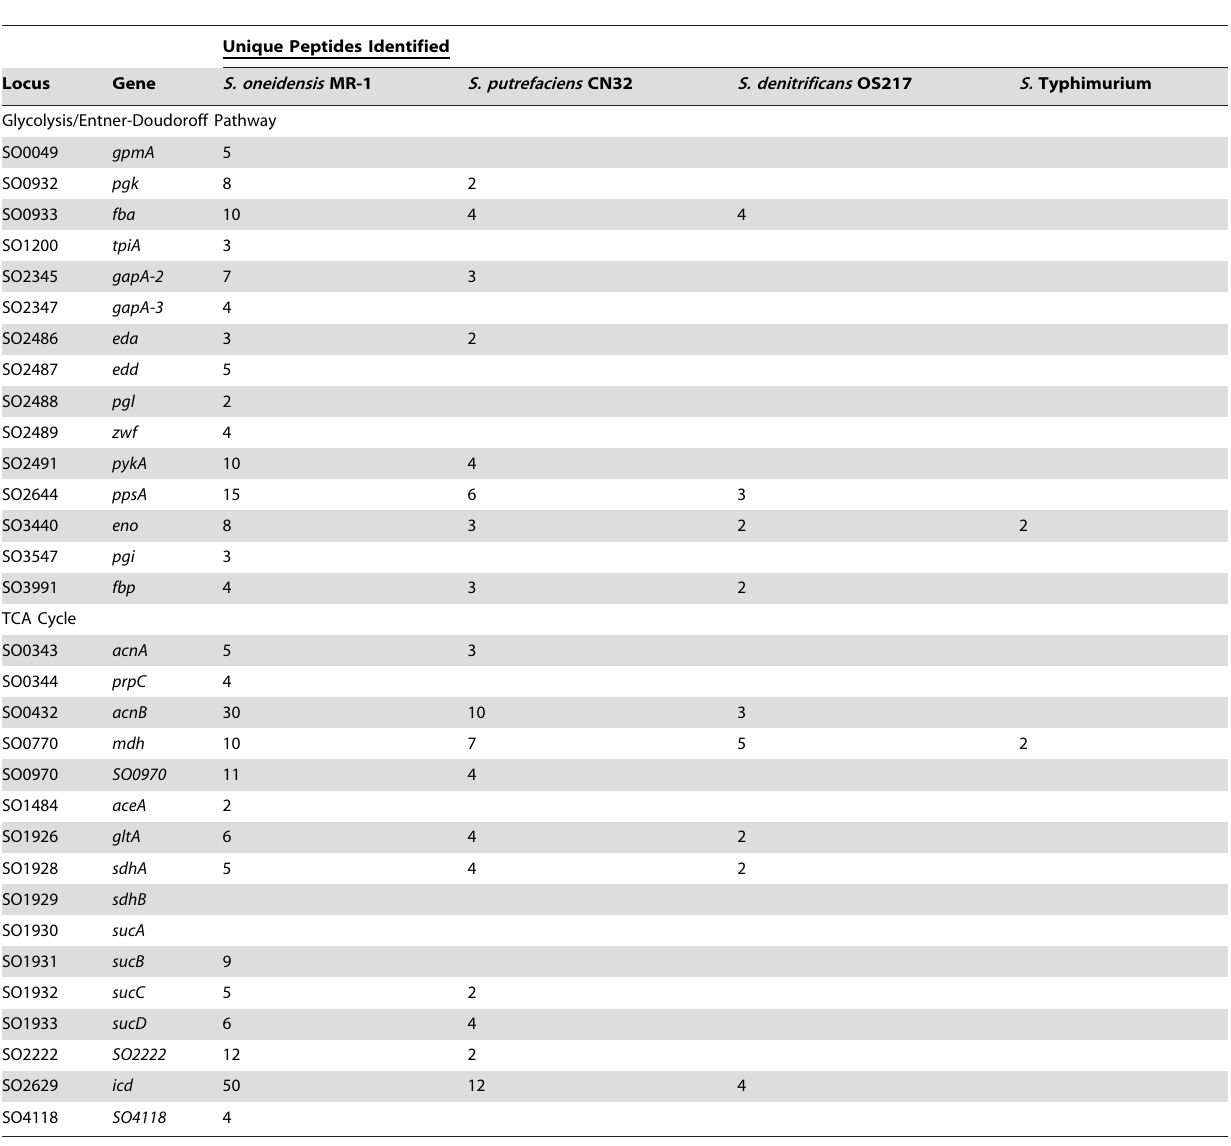
Table 3. S. oneidensis MR-1 peptide fragmentation patterns where mapped to theoretical spectra from organisms representing near, mid, and distant phylogenetic